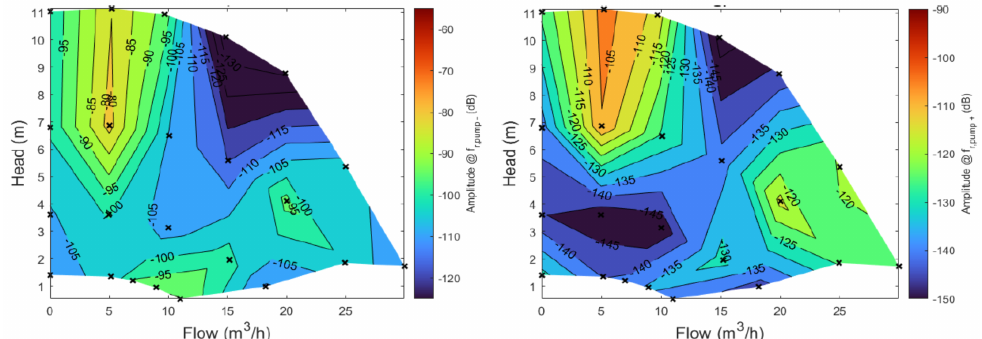
Figure 8. LoPoFIA for the fault indicators f r , pump − and f r , pump + for a pump with a one-sided bearing defect (B-bearing defect).